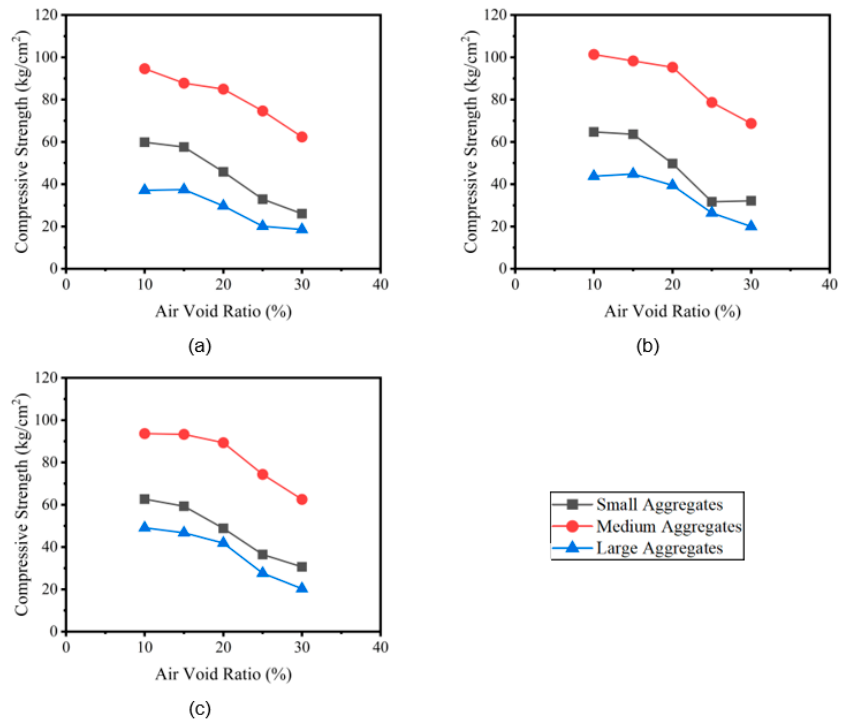
Figure 6. Variation of compressive strength (at 28th day) of PPCC with an air void ratio: ( a ) natural aggregate PPCC, ( b ) recycled aggregate PPCC, and ( c ) recycled aggregate PPCC strengthened with sackcloth fibers. Table 5. Unit weight and water absorption characteristics of natural and recycled aggregates.